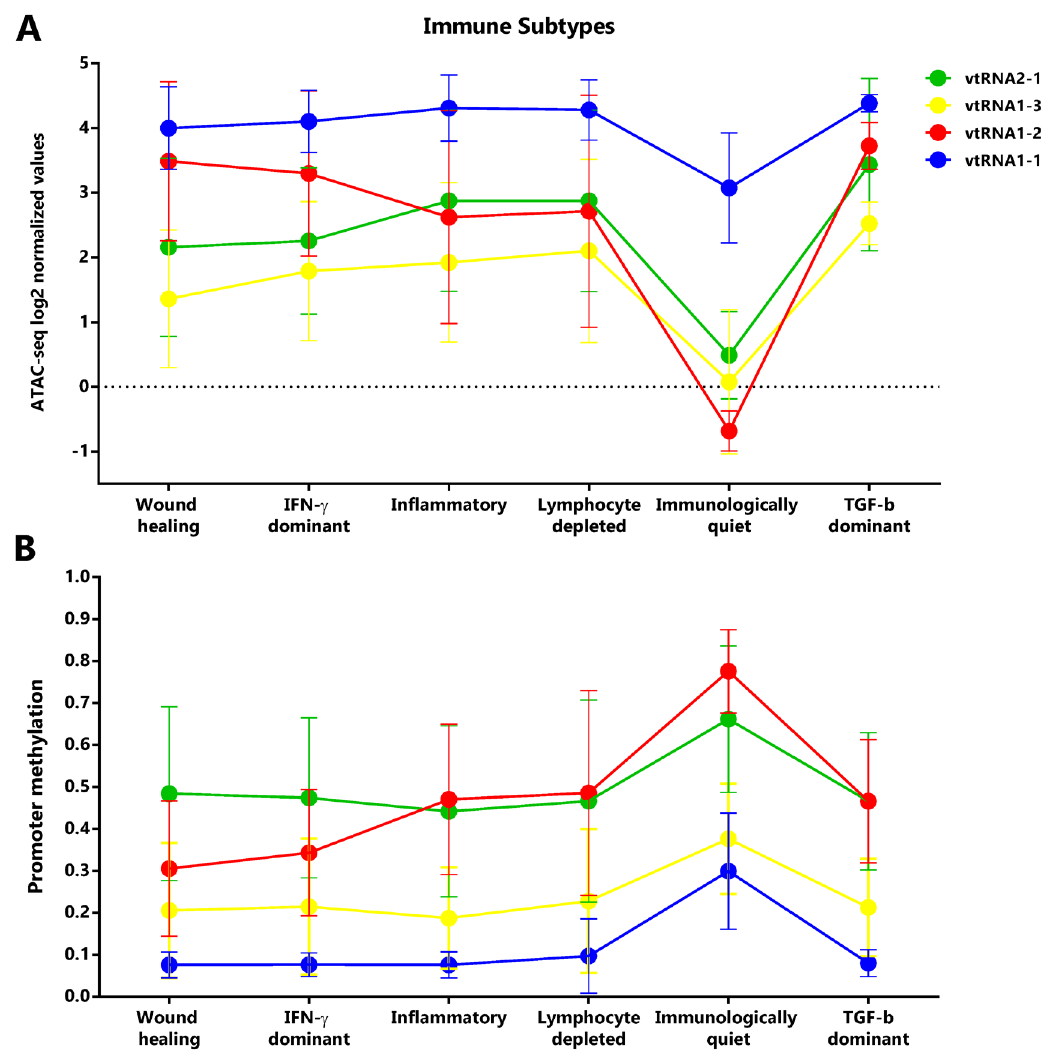
Figure 8. Chromatin accessibility and DNA methylation of vtRNA promoters in the Six Immune Subtypes analyzed in the PANCAN TCGA dataset. A. ATAC-seq values expressed as log2 normalized values for vtRNA promoters grouped in six Immune Subtype: wound healing (105 samples), IFN-g dominant (93 samples), inflammatory (110 samples), lymphocyte depleted (43 samples), immunologically quiet (9 samples), TGF-b dominant (4 samples). B. DNA methylation average beta-values for vtRNA promoters grouped in six Immune Subtype: wound healing (1963 samples), IFN-g dominant (2137 samples), inflammatory (2126 samples), lymphocyte depleted (933 samples), immunologically quiet (383 samples), TGF-b dominant (151 samples) ( Thorsson et al ., 2018 ). The charts show the average and standard deviation for each vtRNA promoter in each Immune Subtype